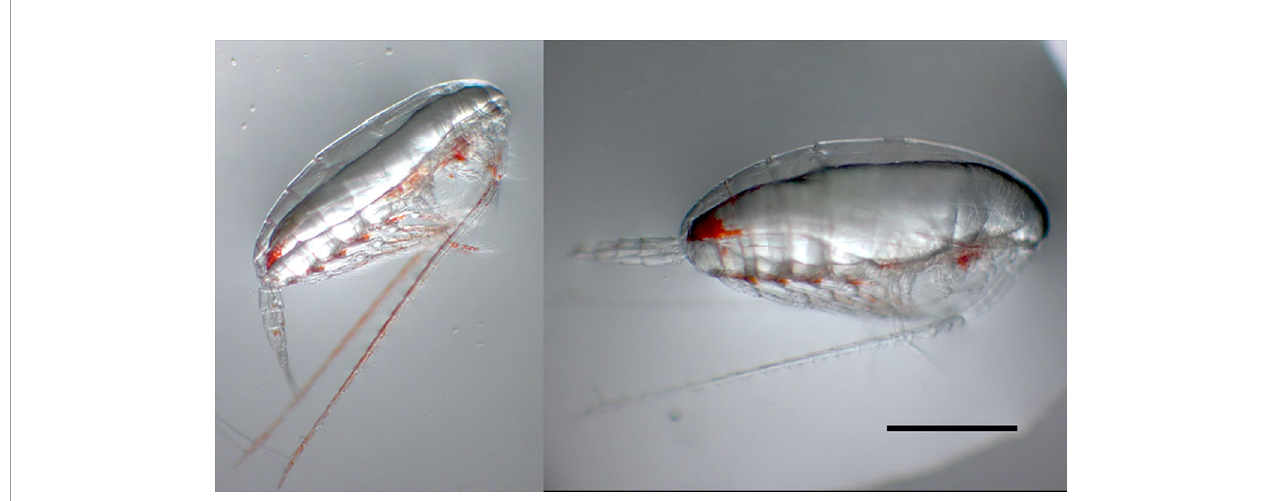
FIGURE 3 | Representative images of C. fi nmarchicus CV from epi- (left) and mesopelagic depths (right) at slope station D6, showing larger body sizes and lipid sacs in deeper animals. Scale bar = 1mm.